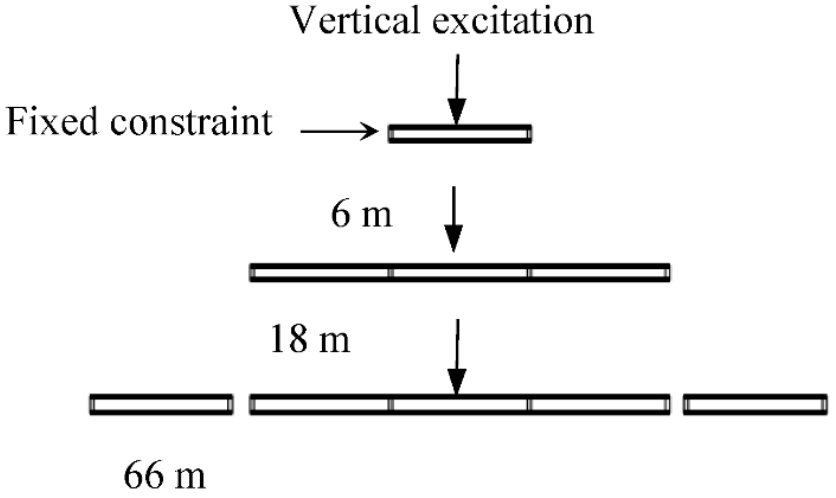
Figure 9. Loading case of the rigid catenary model with different section lengths.